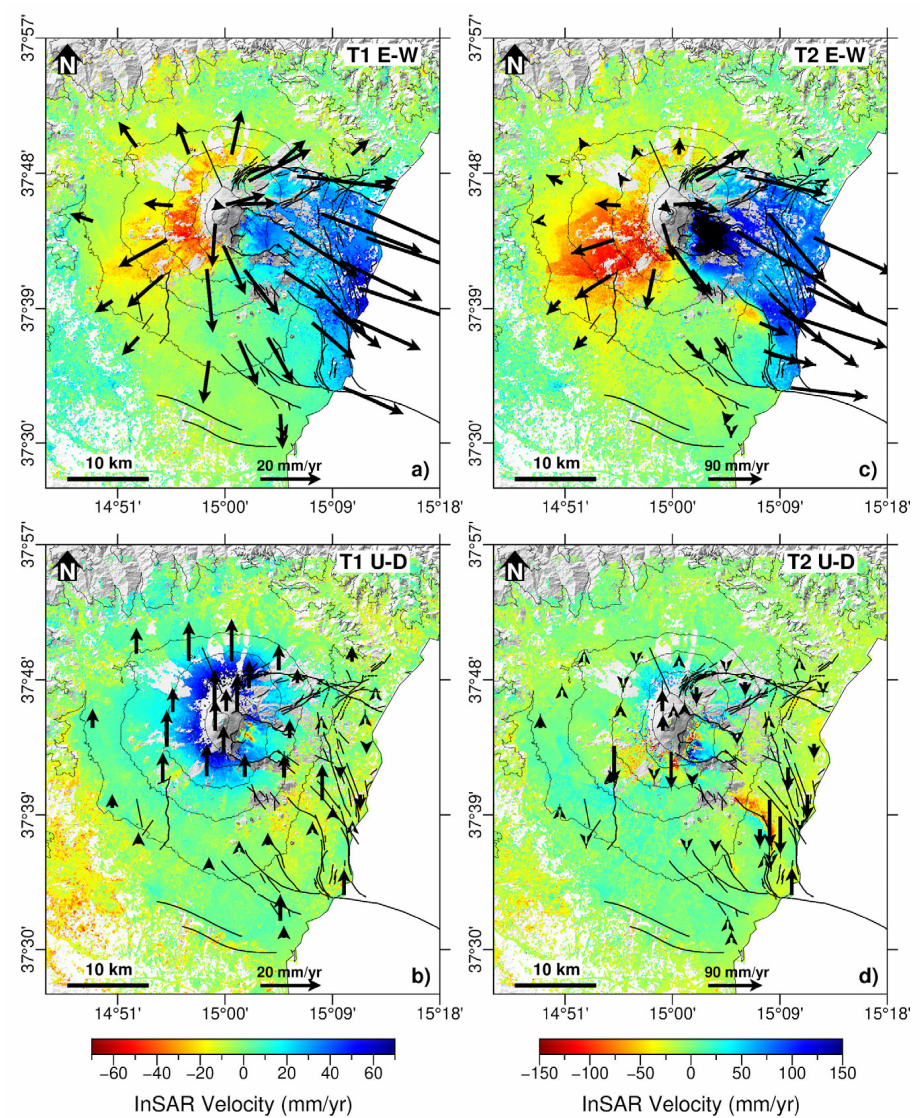
Figure 5. Horizontal (panels a , c ) and vertical (panels b , d ) component velocity maps relative to T1 (18 January 2015–22 December 2018) and T2 (28 December 2018–2 June 2019) time intervals. Positive values (blue colors) represent scatterers eastward in panels ( a , c ); and uplifting in panels ( b , d ). Negative values (red colors) are moving westward in panels ( a , c ), and subsiding in panels ( b , d ). GNSS velocity vectors of the horizontal and vertical components relative to the same time period are reported for each panel as black